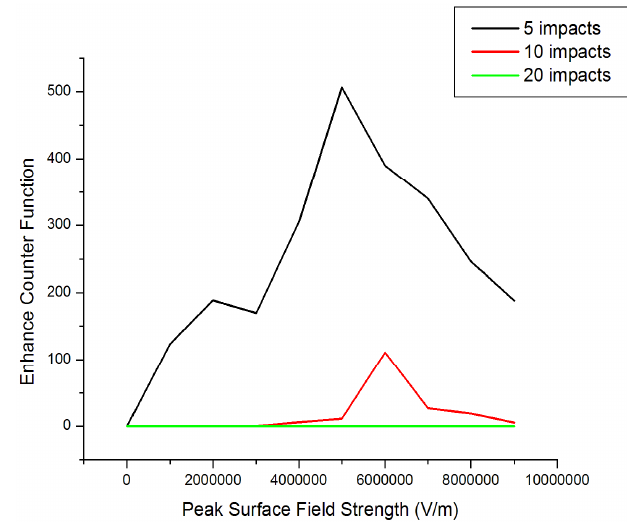
FIG. 6. (Color) Electron trajectories between surfaces of the stem and housing cylinder.